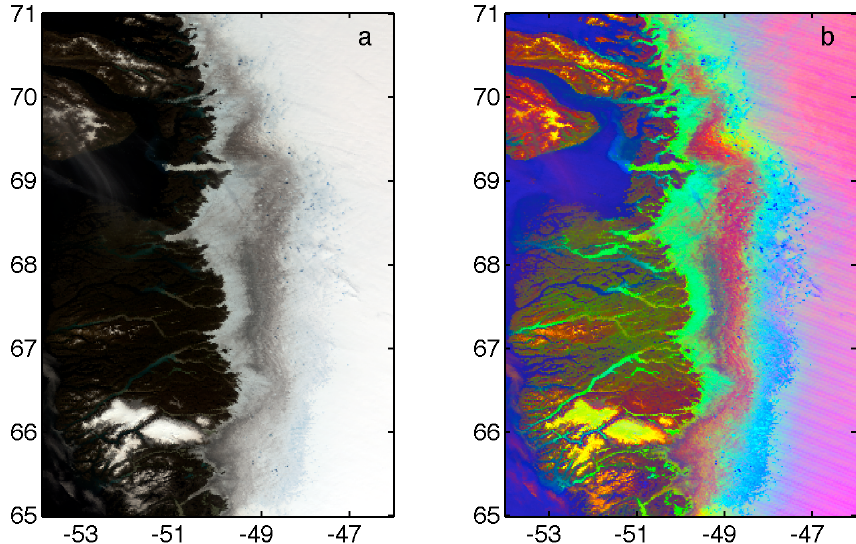
Fig. 2. True colour composites of the MODIS image from 9 August 2007: (a) with linear stretch; (b) with decorrelation